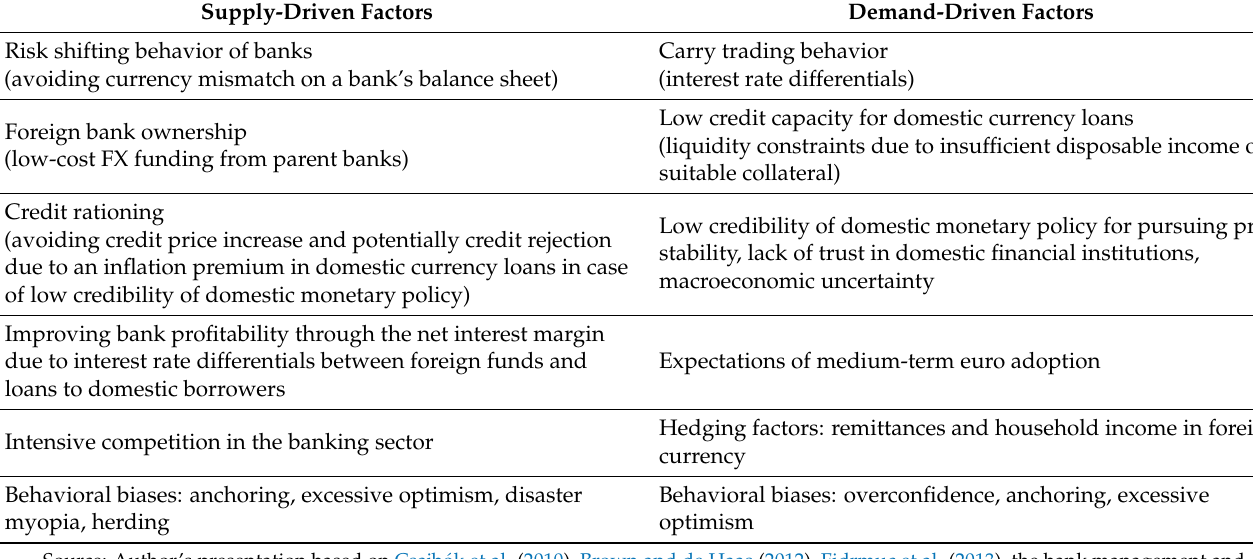
Table 3. Determinants of adopting households FX